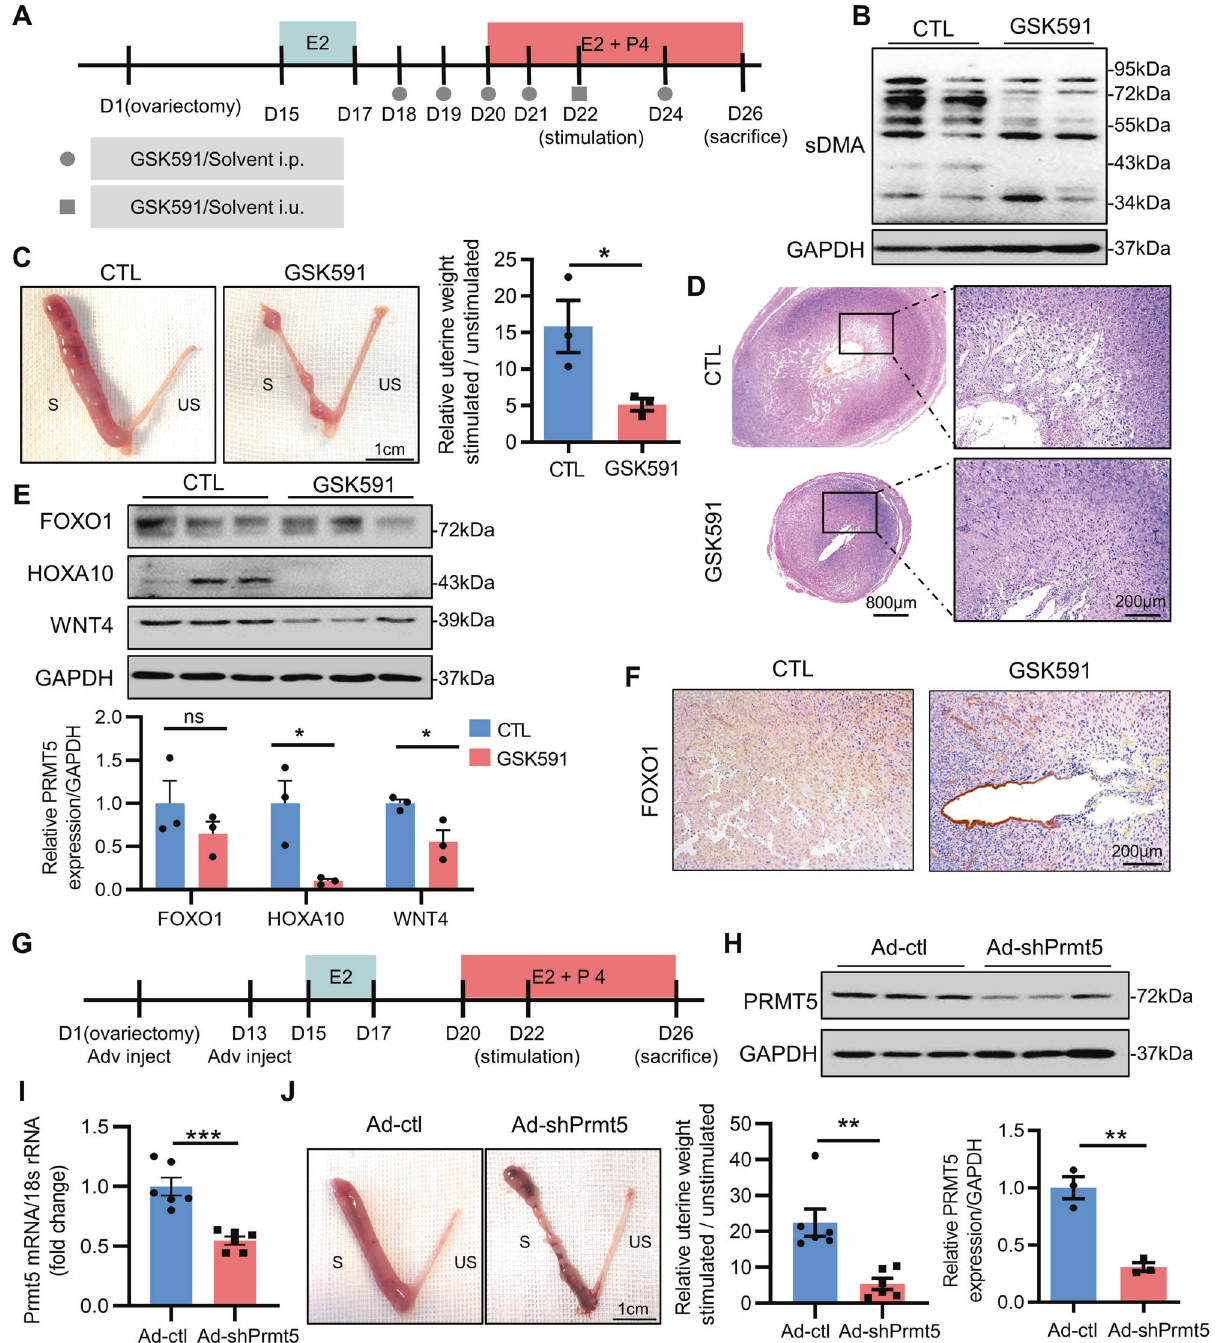
Fig. 3 PRMT5 is required for endometrial decidualization in mice. A Schematic representation of stimulated decidualization procedures with GSK591 treatment. B Western blot analysis of SDMA level in the stimulated uteri from the control and GSK591 groups. C Gross morphology of the unstimulated or stimulated uterine side and the ratio of stimulated to unstimulated uterine weight from the control (CTL) and GSK591 groups, scale bar = 1 cm. D Hematoxylin-eosin staining of the stimulated uteri from the control and GSK591 groups, scale bars = 800 µm (left panel) and 200 µm (right panel). E Western blot analysis of FOXO1, HOXA10 and WNT4 expression in the stimulated uteri from the control and GSK591 groups. F IHC assay of FOXO1 in the stimulated uterus from the control and GSK591 groups, scale bar = 200 µm. G Schematic representation of stimulated decidualization procedures with treatment by an adenovirus harboring sh-PRMT5. H Western blot analysis of PRMT5 expression in the stimulated uteri from the control (Ad-ctl) and Ad-shPRMT5 groups. I qRT – PCR analysis of PRMT5 mRNA in the stimulated uteri from the Ad-ctl and Ad-shPRMT5 groups. J Gross morphology of unstimulated or stimulated uterine side and the ratio of stimulated to unstimulated uterine weight from the Ad-ctl and Ad-shPRMT5 groups, scale bar = 1 cm. i.p. intraperitoneal injection, i.u. intrauterine injection, S stimulated, US unstimulated. * P < 0.05, ** P < 0.01, Student ’ s t